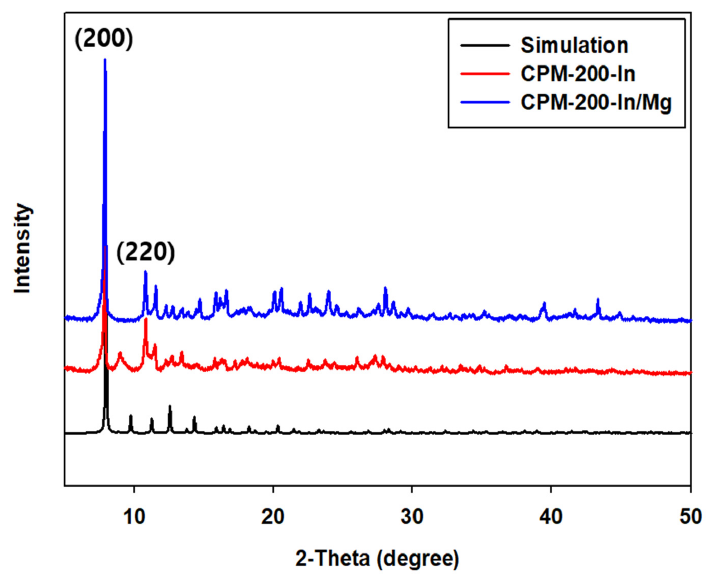
Figure 1. XRD patterns of crystalline porous materials (CPM)-200-In and CPM-200-In/Mg with simulated CPM-200 (Cambridge Crystallographic Data Center (CCDC) number: 1444375).